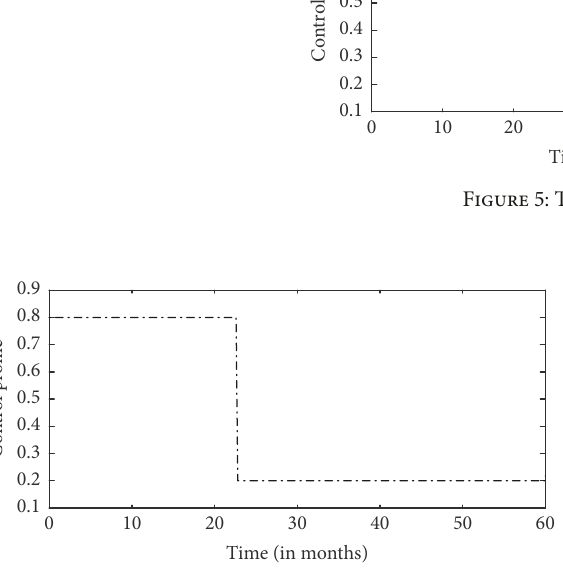
Figure 6: The control profile with high